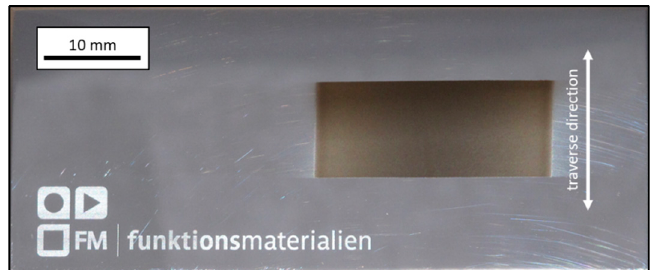
Figure 4. Image of 25 × 10 mm² EAC-1 coating (dark grey) on a polished stainless steel substrate (70 × 30 mm²). The double arrow indicates the traverse direction of the substrate table. Film thickness approx. 3 µm, deposition time 2 min.